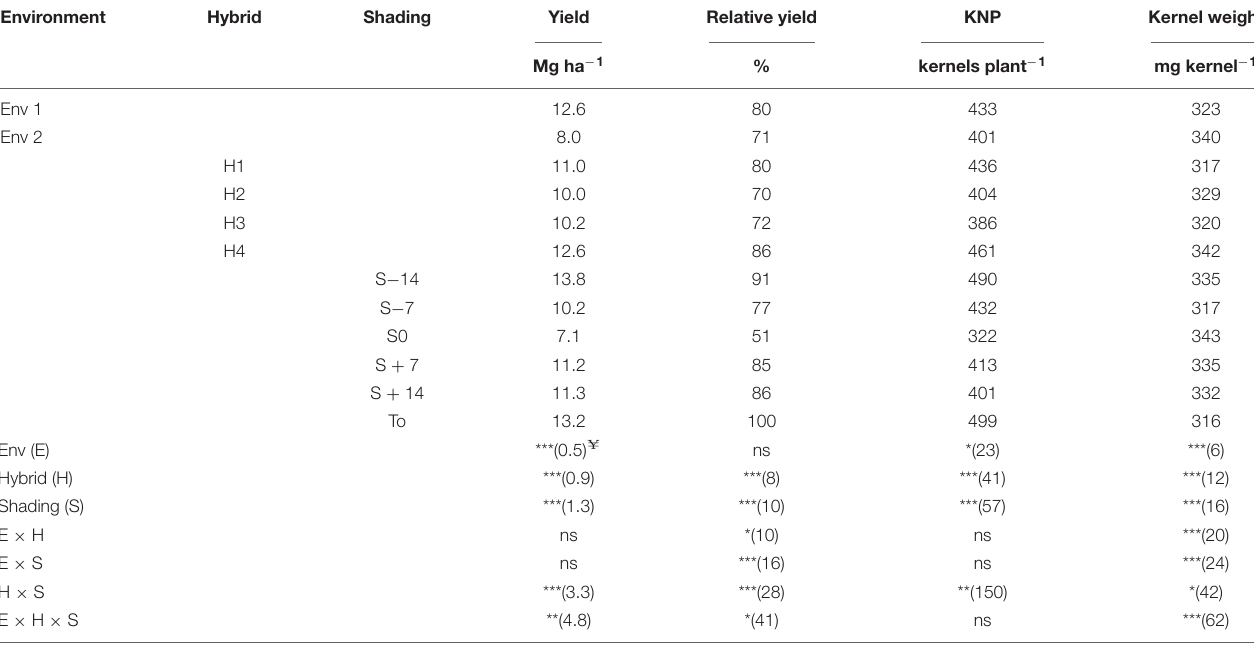
TABLE 1 | Yield, relative yield (yield relative to the T0 control treatment), kernel number per plant (KNP), and individual kernel weight (KW) for four genotypes tested at six reduced radiation treatments (S − 14, S − 7, S0, S + 7, S + 14, and T0) in two different environments (Env 1 and Env 2). Environment Hybrid Shading Yield Relative yield KNP Kernel weight